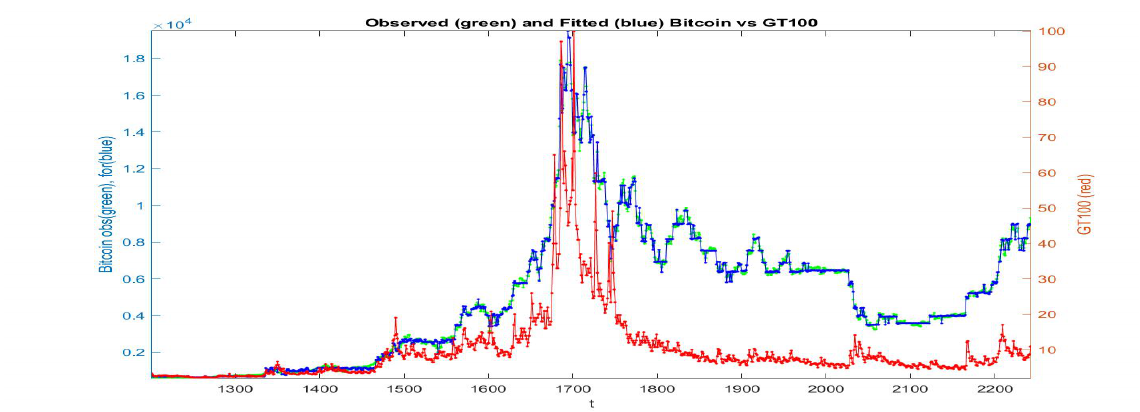
Figure 10. Clustering B: the fitted BitCoin time series (blue colour) is obtained from L 2 -norm iF-transform function applied to the data-set ( GT 100 t , BitCoin t ) ; the observed BitCoin t values are green and the observed GT 100 t values are red.